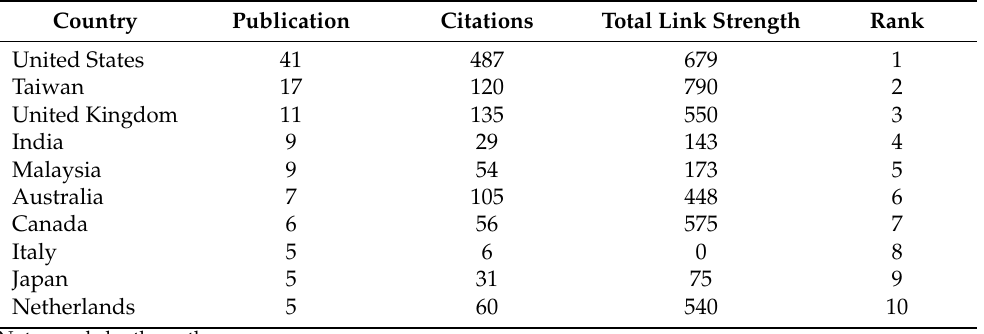
Table 1. Top 10 countries by publications.